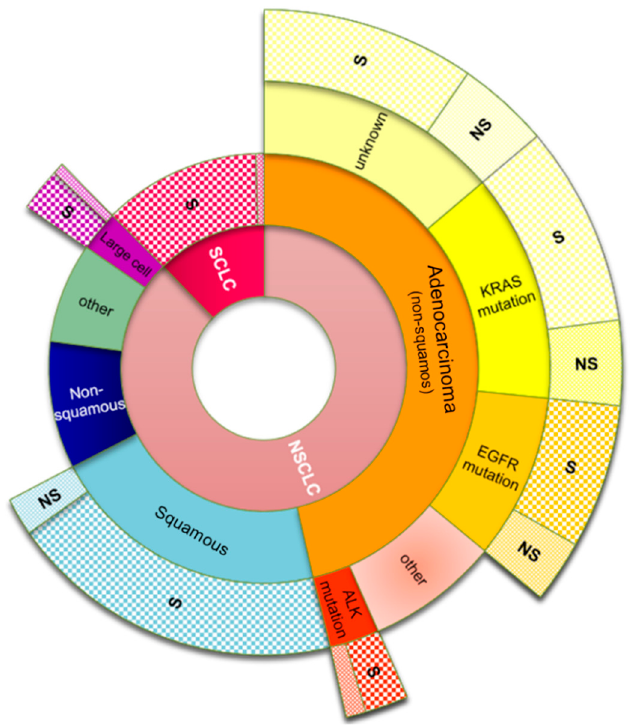
Figure 3. Multistep classification of lung cancer subtypes; common mutations that occur in adenocarcinoma tumors and the occurrence ratio caused by smoking tobacco for each subtype. Abbreviations: SCLS: small-cell lung carcinoma; NSCLC: non-small-cell lung carcinoma; EGFR: epidermal growth factor receptor; KRAS: Kirsten rat sarcoma; ALK: anaplastic lymphoma kinase; S: smokers; NS: non-smokers. Data adapted from Zago et al., Naidoo et al., Kenfield et al. [119–122].